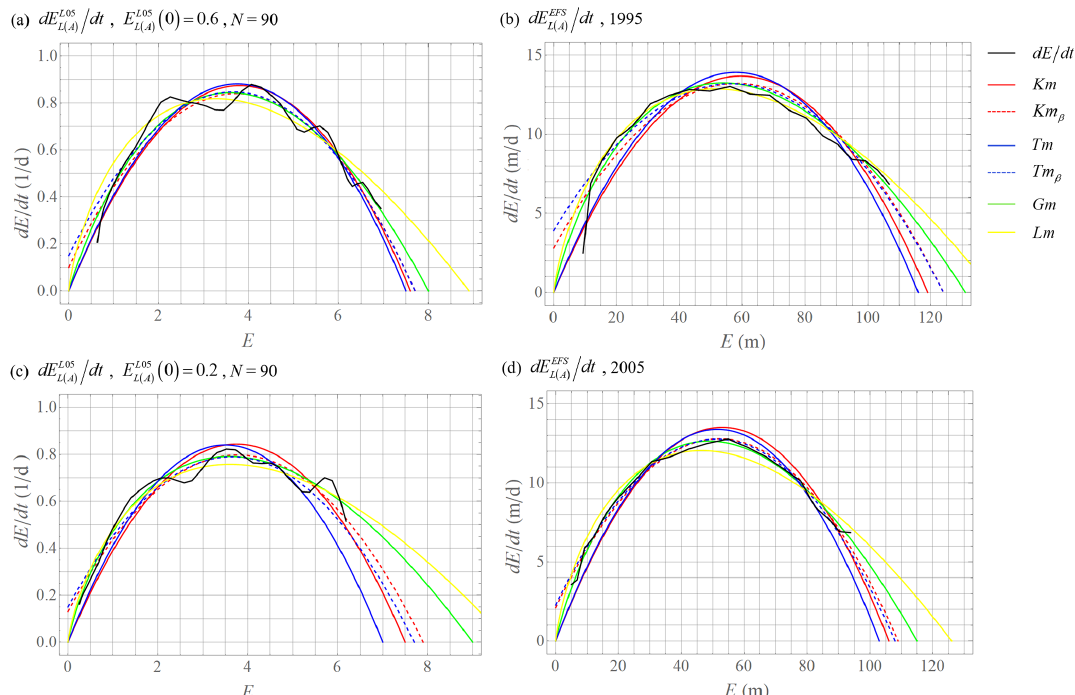
Figure 4. Approximations of differences of lower-bound predictability curves (representative samples). (a, b) The most similar predictability curves in the year 1995 of the ECMWF forecasting system. (c, d) The most similar predictability curves in the year 2005 of the ECMWF forecasting system. Tm displays parameters from Tm used in Km, and Tm β displays parameters from Tm β used in Km β .